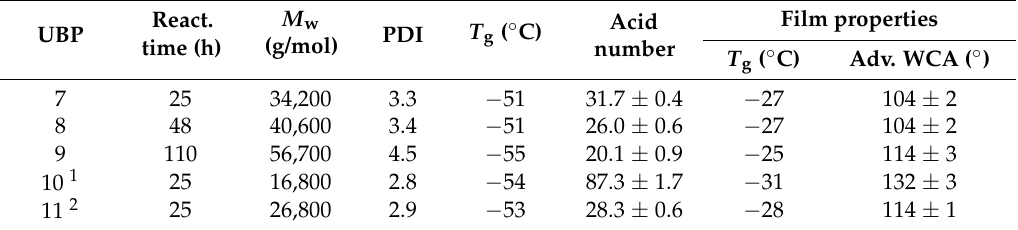
Table 2. Molar masses and glass transition temperatures of the UBPs containing PTA, glycerol, TOFA as well as glass transition temperatures and WCA determined for the coated and crosslinked